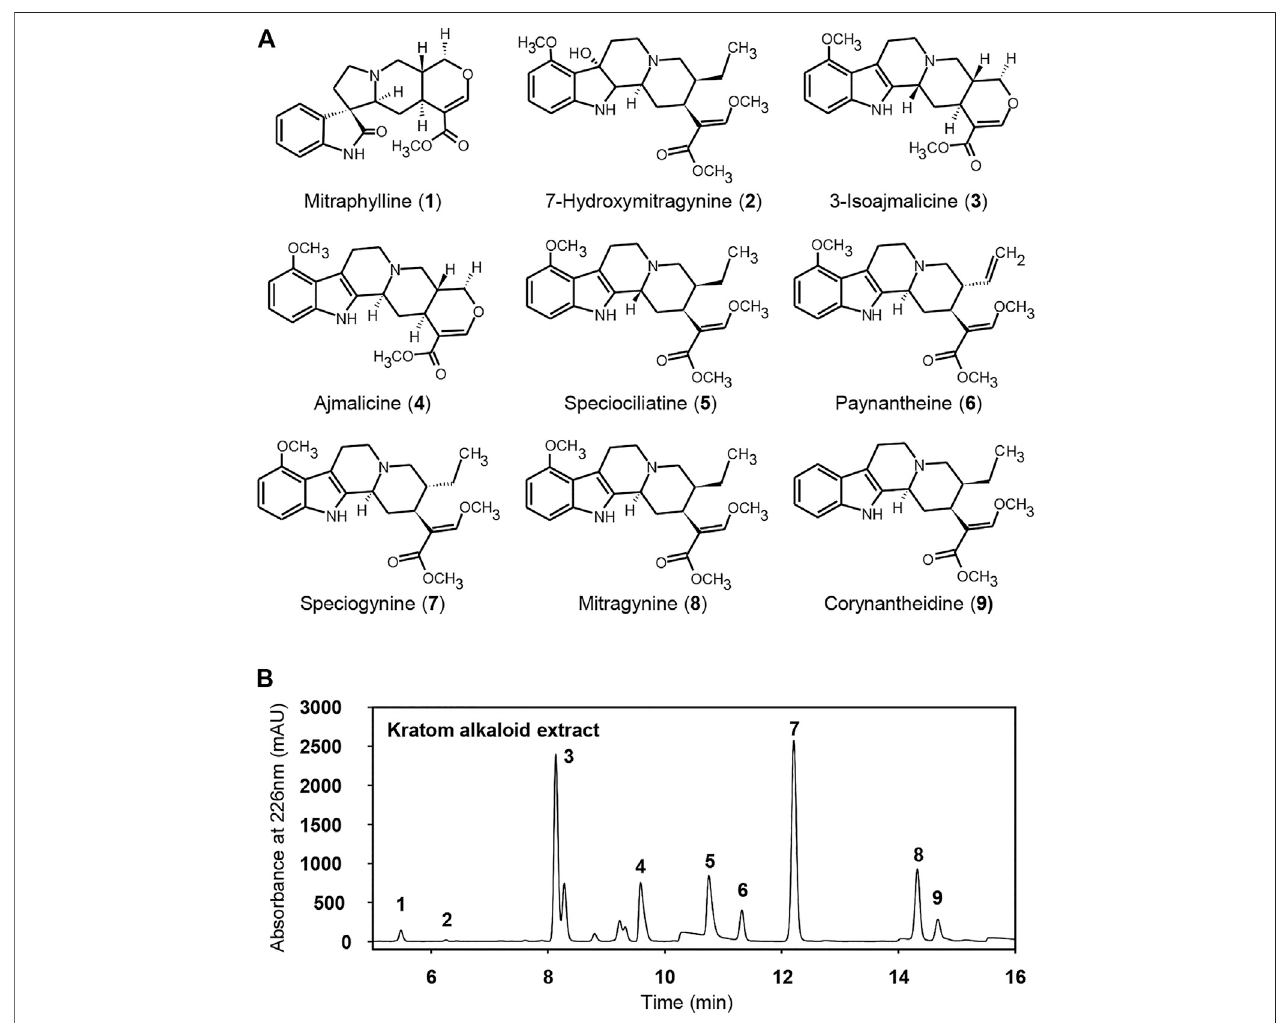
FIGURE 1 | Constituent alkaloids in whole kratom extract. (A) Compound structures and (B) HPLC chromatogram of the alkaloid pro fi le of the kratom leaves extract at 226 nm. The peaks represent respectively: 1, mitraphylline; 2, 7-hydroxymitragynine; 3, 3-isoajmalicine; 4, ajmalicine; 5, speciociliatine; 6, paynantheine; 7, speciogynine, 8, mitragynine, and 9, corynantheidine.